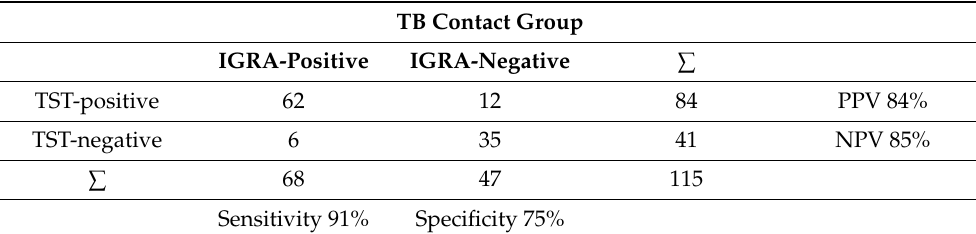
Table 3. Sensitivity, specificity, positive predictive value (PPV), and negative predictive value (NPV) for TST in correctly identifying IGRA positivity in TB contact volunteers.